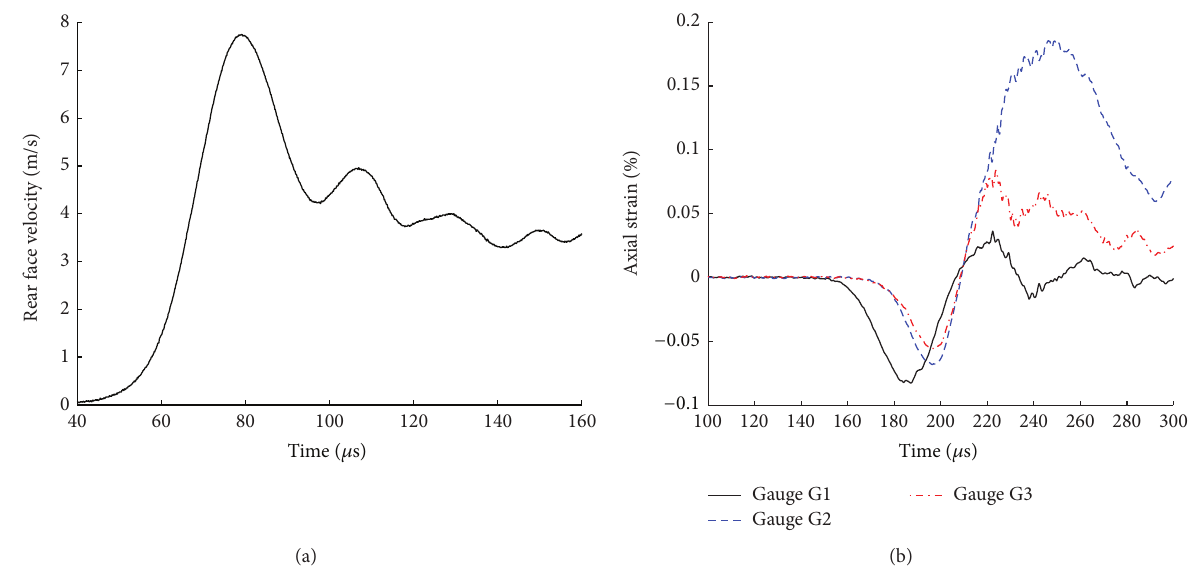
Figure 2: Spalling test results for a specimen without preexisting cracks. Rear face velocity profile from the laser (a) and strain data from the three strain gauges (b).